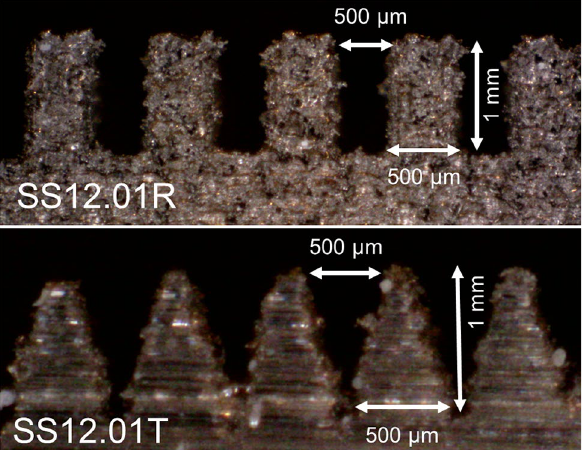
Figure 9. Two micro-grooves considered, rectangular (SS12.01R) and triangular (SS12.01T) cross-sections made with direct metal laser sintering (DMLS). The triangular cross-section has a higher capillary height as compared to the rectangular one, see the results. Table 1 lists the sample details.